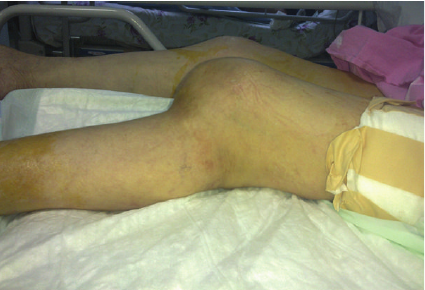
Figure 3: The deformed knee indicating posterior knee